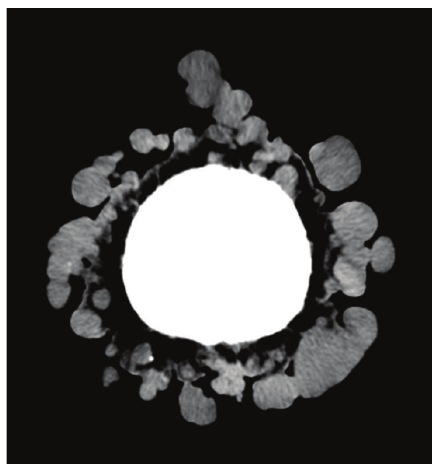
Figure 3: Noncontrast head CT: multiple nodular smooth surfaced well-demarcated soft tissue lesions arising from the